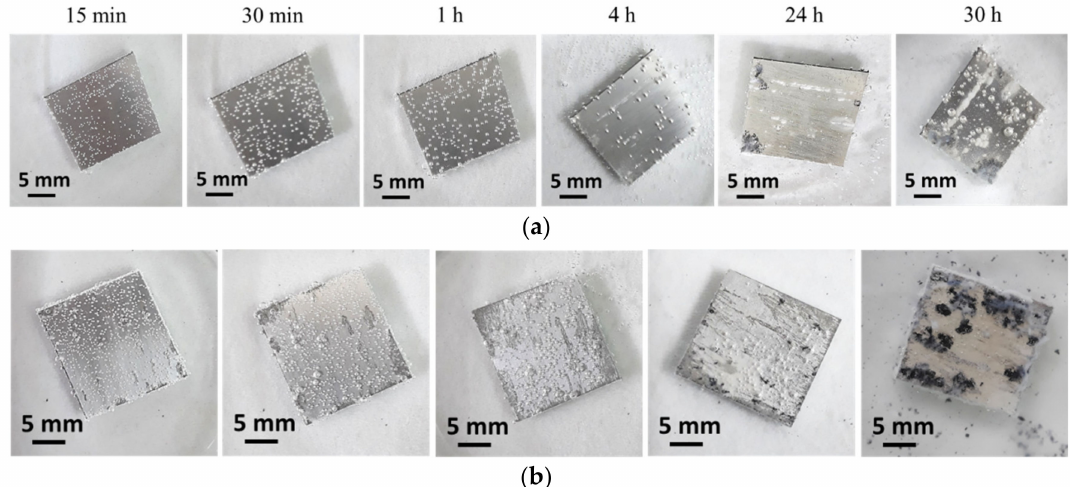
Figure 6. Optical micrographs showing the surface of ( a ) AM60; ( b ) AMX601 alloys during the immersion in 3.5 wt% NaCl solution saturated with Mg (OH) 2 at room temperature.